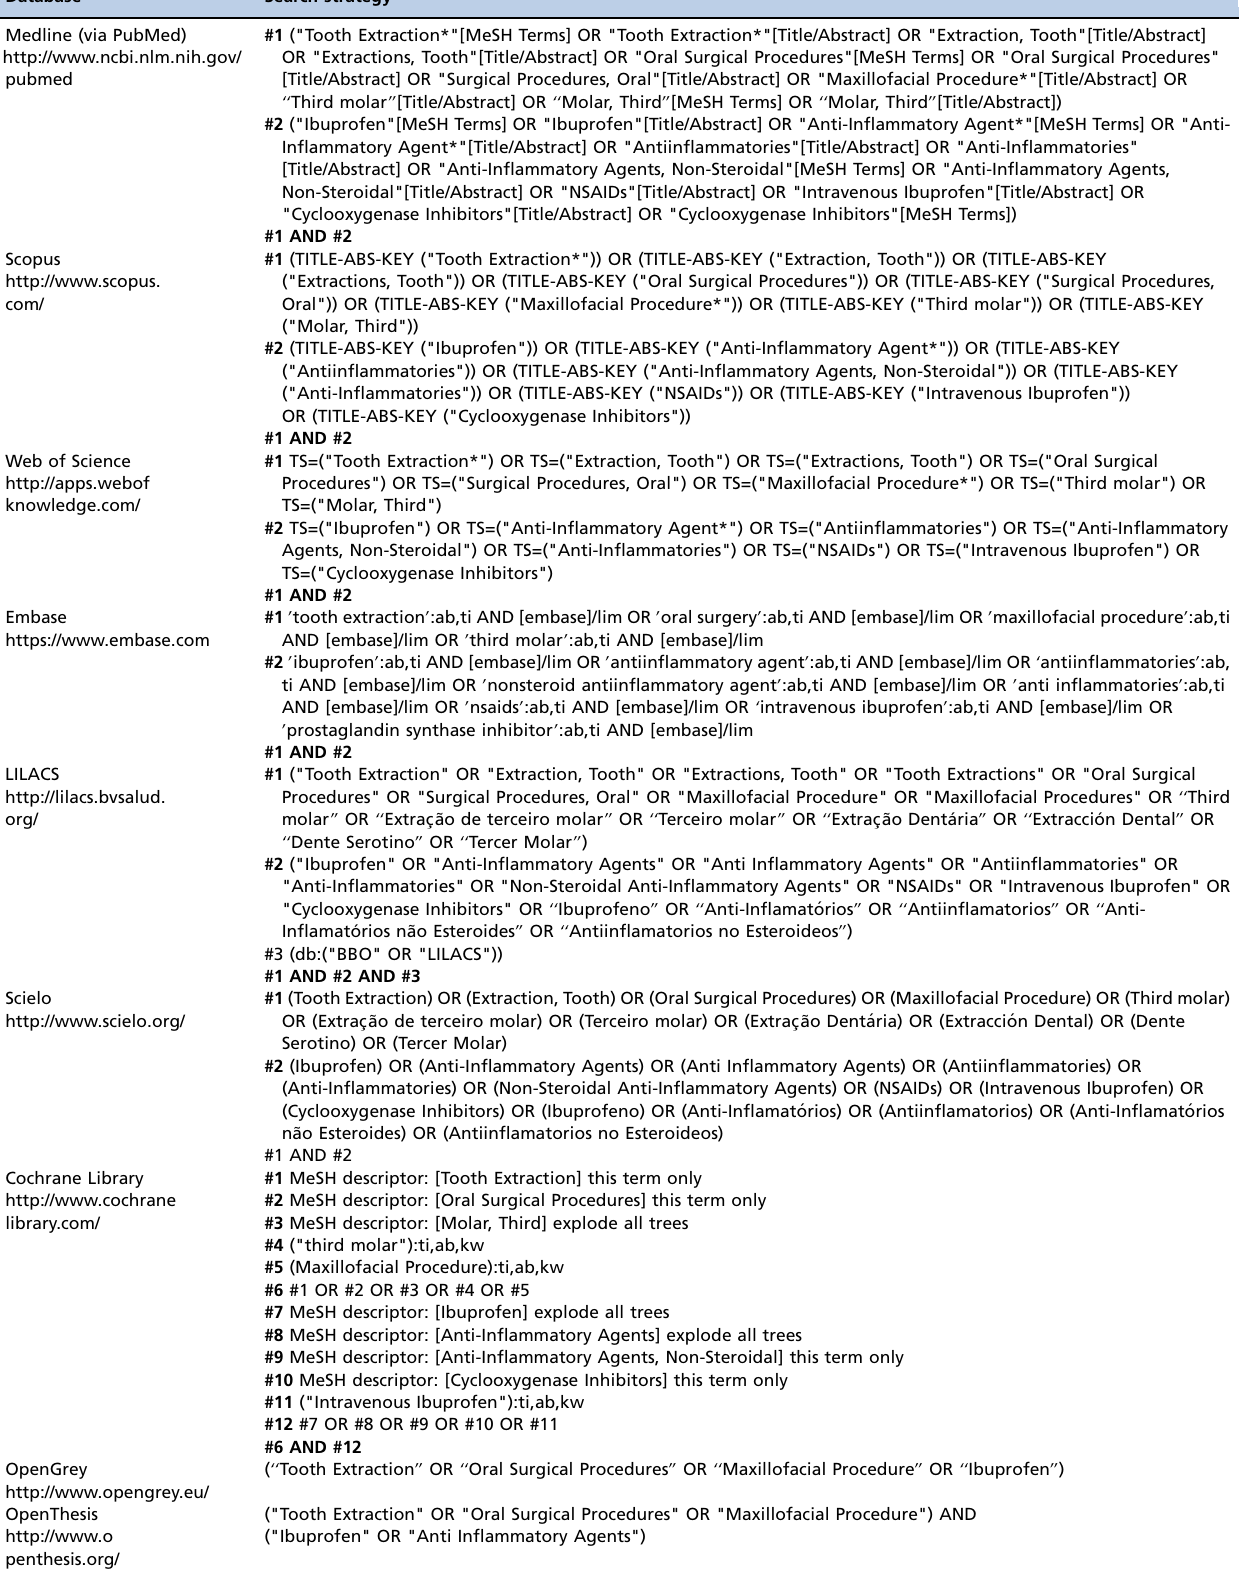
Table 1 - Strategies for database search.